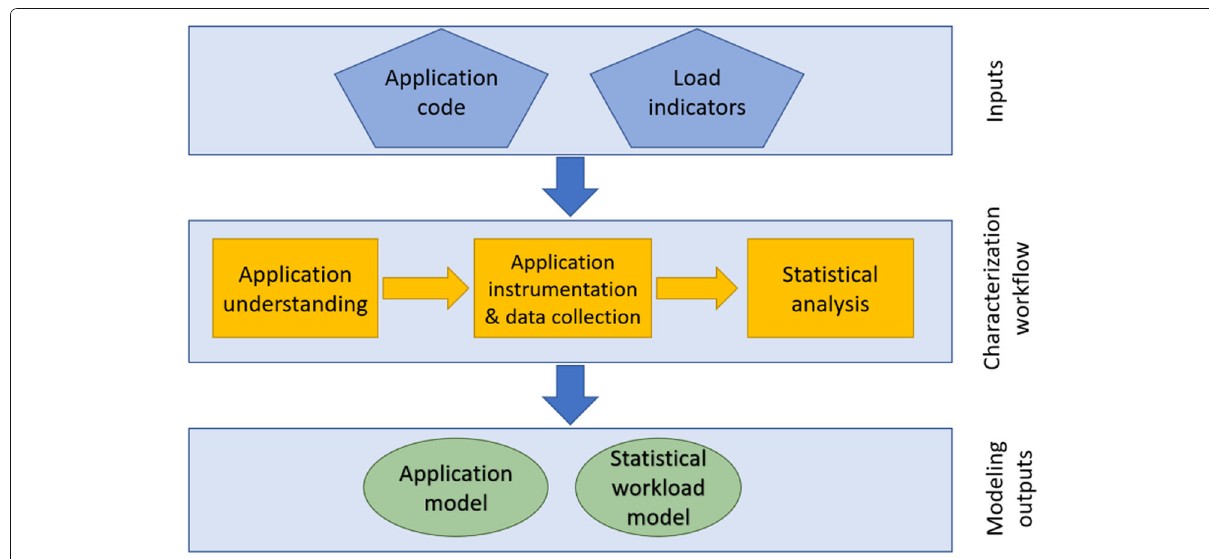
Fig. 11 Characterization and modeling